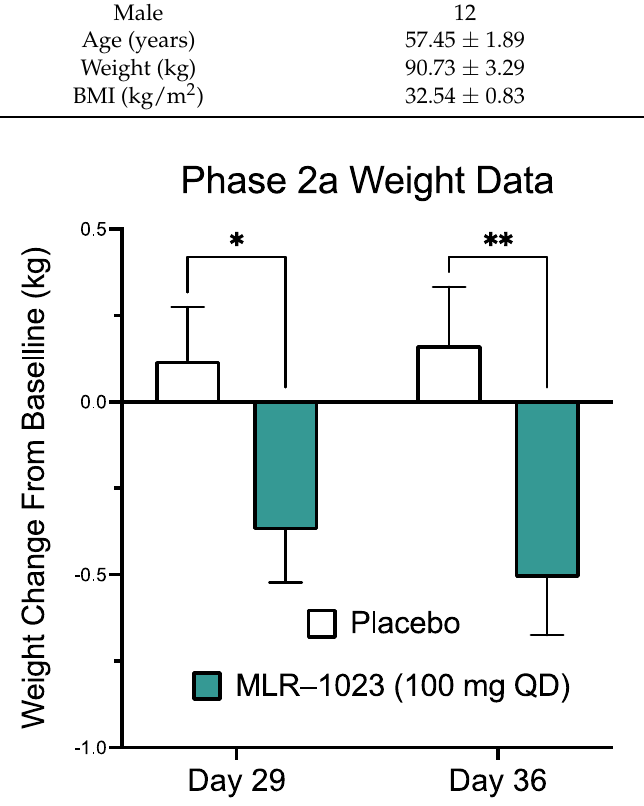
Figure 9. Clinical Trial of MLR-1023 vs. placebo. The study was a randomized double-blinded placebo-controlled parallel-arm phase II trial to investigate the effect of MLR-1023 on body weight in adults with type 2 diabetes. Body weight was measured at baseline, at day 29, and at day 36. Values are mean ± SEM. * p < 0.05. ** p < 0.01.